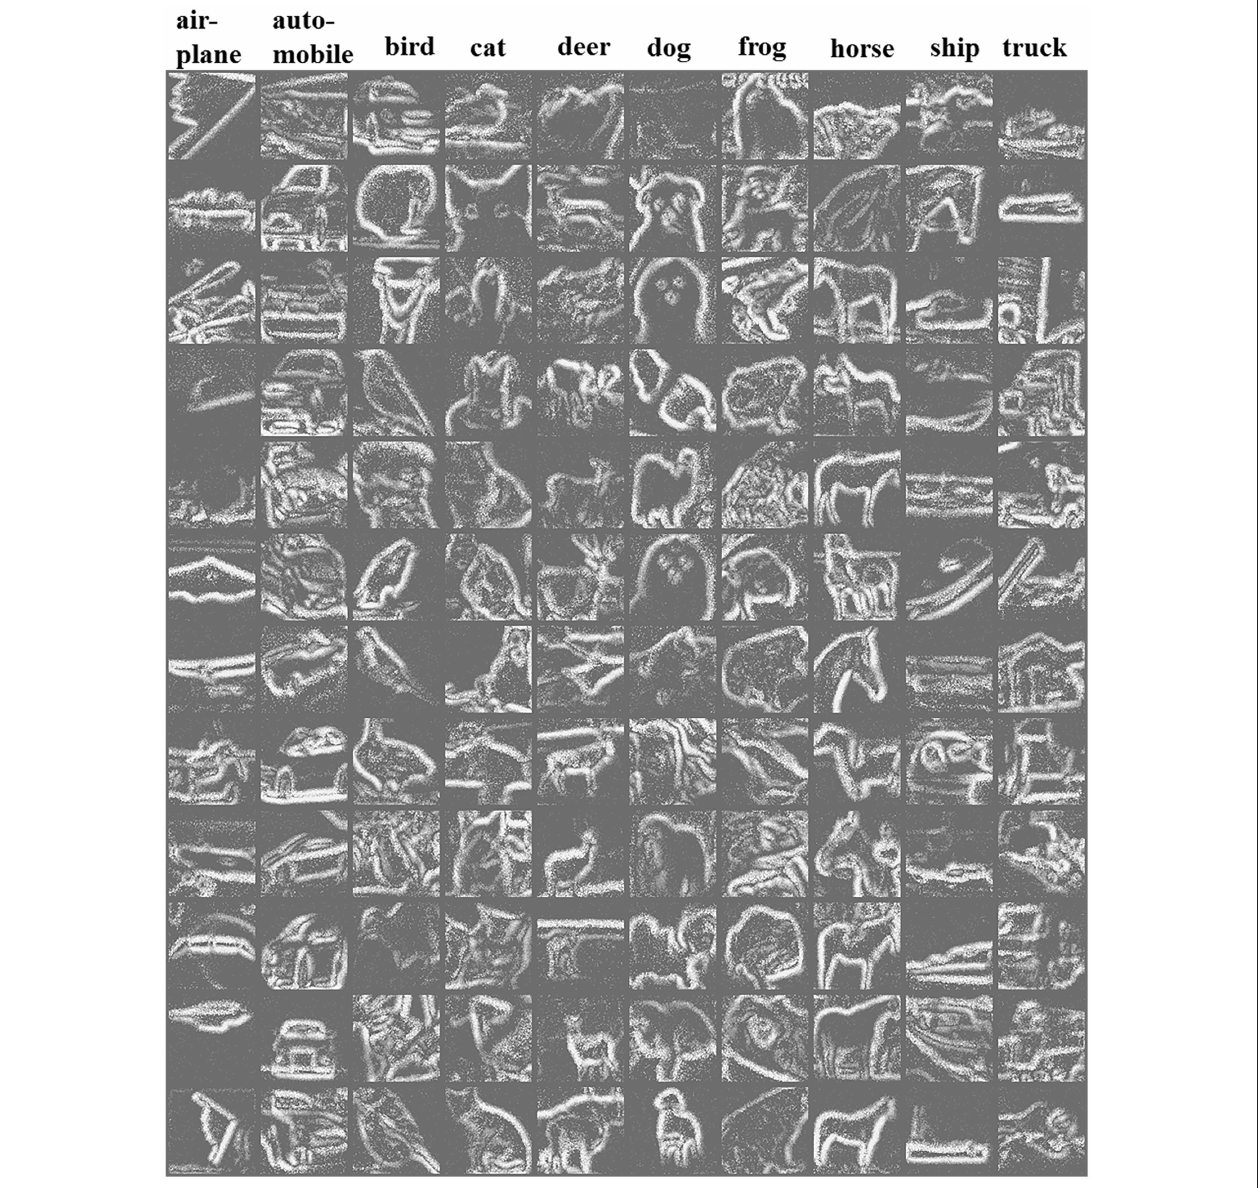
FIGURE 4 | A 12 × 10 matrix of reconstructed frames of randomly selected recordings in CIFAR10-DVS. From left to right columns are AER recordings of 10 categories of airplane, automobile, bird, cat, deer, dog, frog, horse, ship, truck, respectively. In the reconstruction, events over a certain time range are integrated into the corresponding pixel